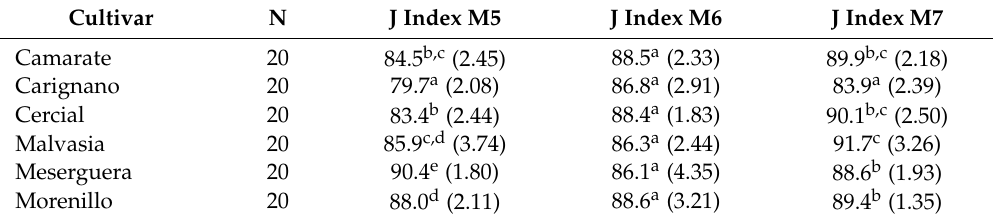
Table 4. Mean values of the J index in six cultivars of Vitis vinifera ssp. vinifera , with the models used (M5, M6 and